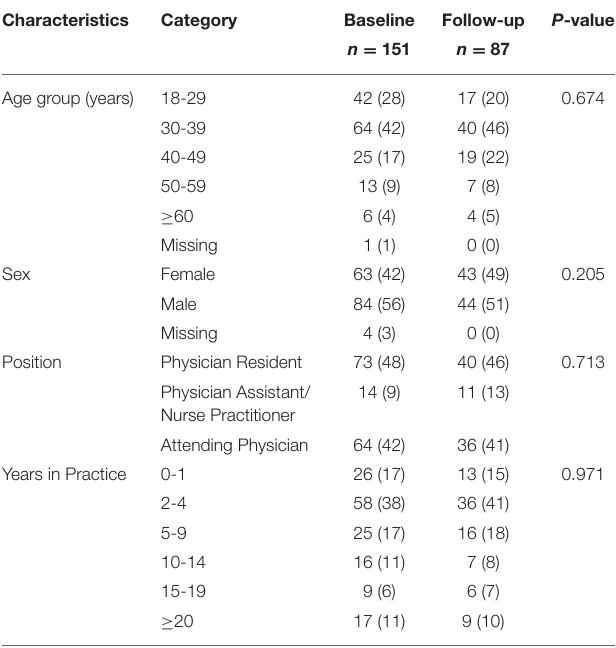
TABLE 1 | Characteristics of participants at the baseline and follow-up survey.